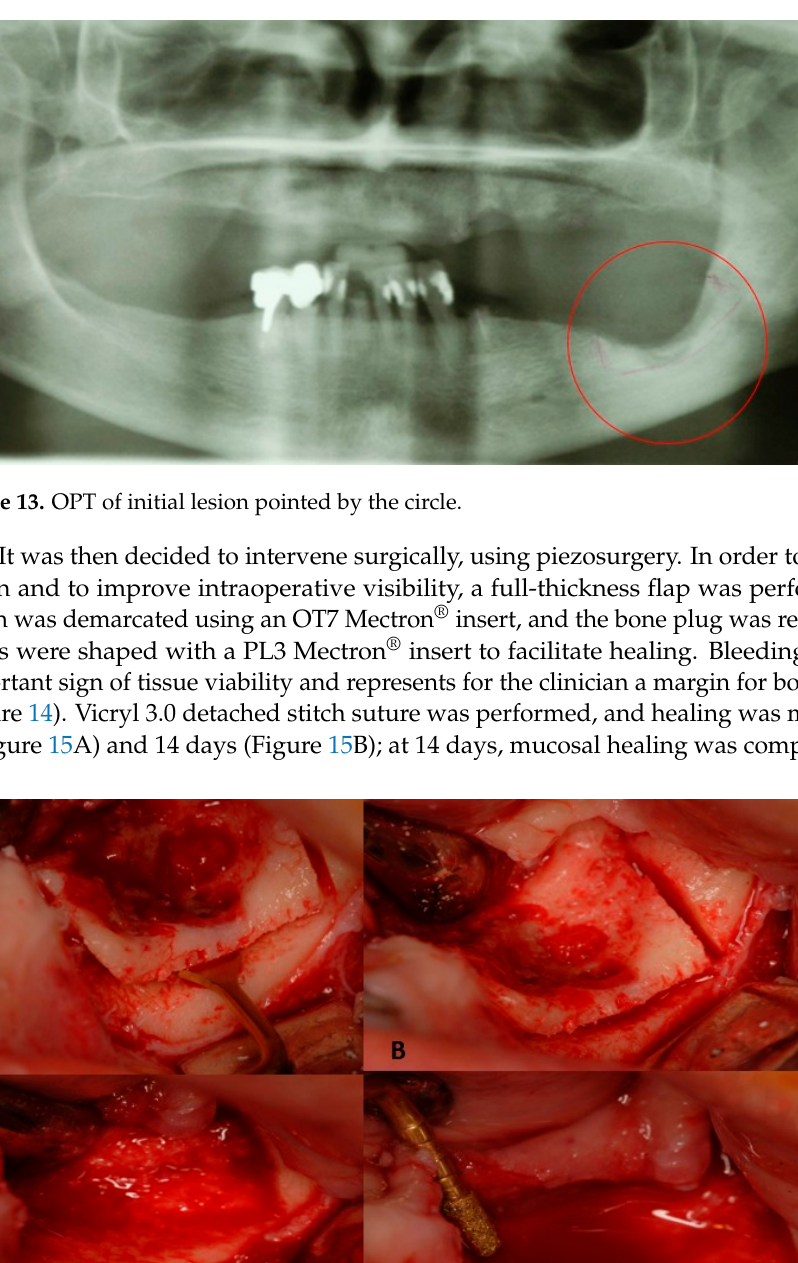
Figure 14. ( A ) Piezo surgery intervention with OT7 Mectron ® tip; ( B ) Delimitation of necrotic area; ( C ) Removal of necrotic bone plug; ( D ) Rounding of lesion margins with PL3 Mectron ® tip.